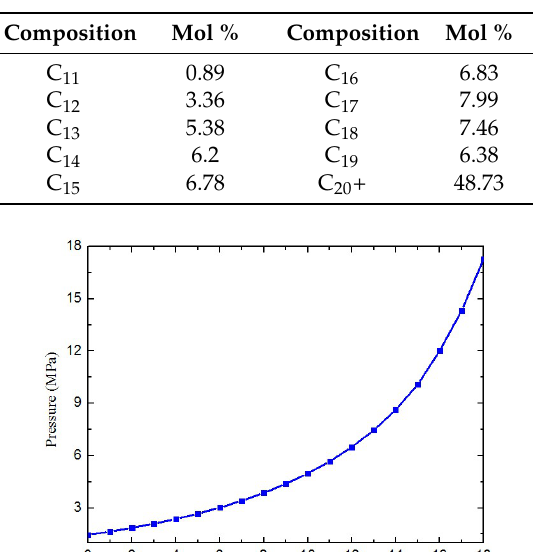
— — Table 2. The composition of − 20# diesel oil. Table 2. The composition of −20# diesel oil.